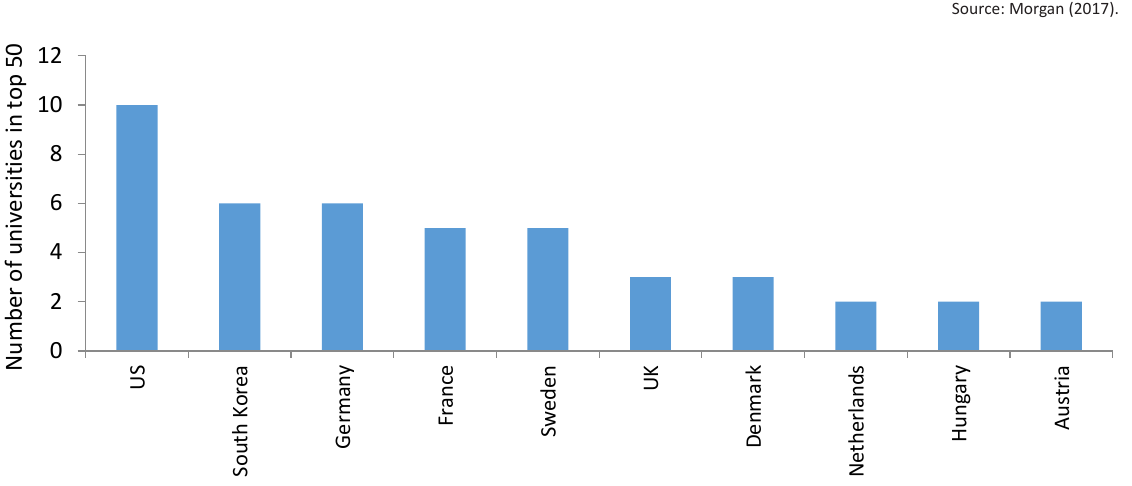
Figure 1. Number of universities in top 50 of world university rankings universities with the most industry